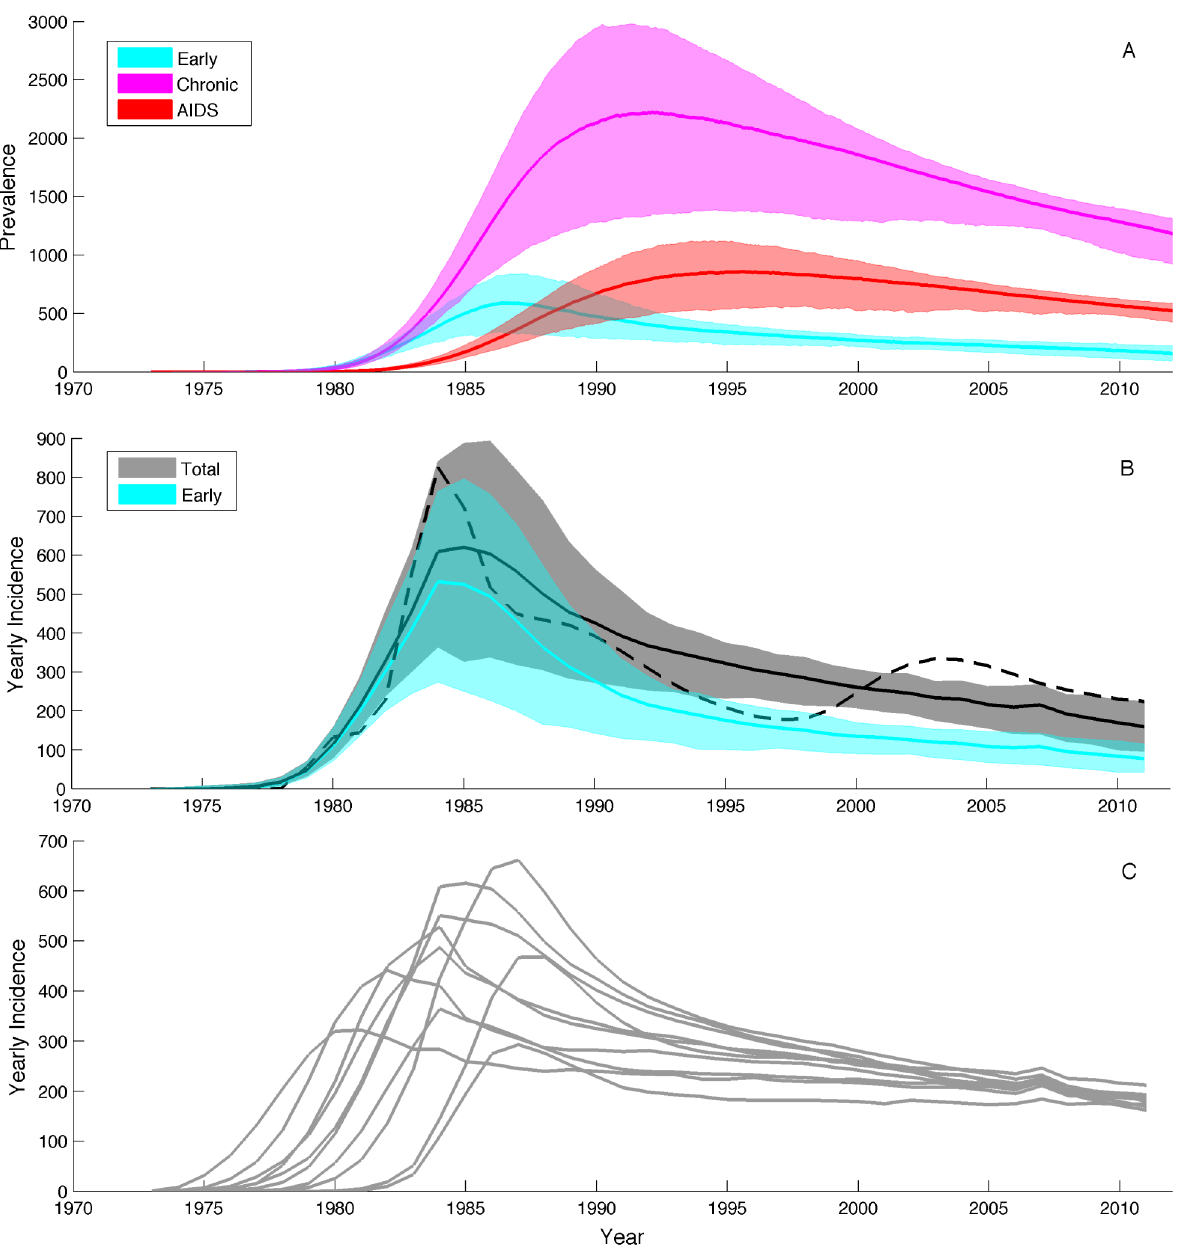
Figure 3. Population dynamics inferred from the Detroit HIV genealogies. (A) Stage-specific prevalence estimates from one genealogy with shaded regions showing the 95% credible intervals and lines the median of the posterior densities. (B) Estimated total yearly incidence and the estimated incidence attributable to early stage infections. The dashed black line shows the incidence back-calculated from Michigan Department of Community Health surveillance data. (C) Total incidence estimated from 10 randomly sampled HIV genealogies.